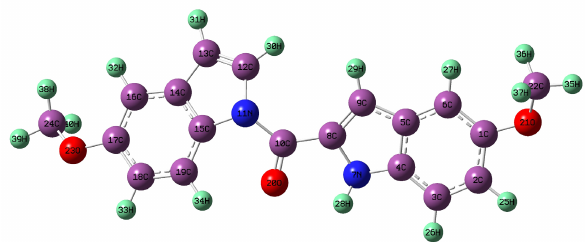
Figure 1 : Optimized geometric structure and atom numbering of MIMIM (C H N O ). Atom colors: carbon (violet), hydrogen (green), 19 16 2 3 oxygen (red), nitrogen